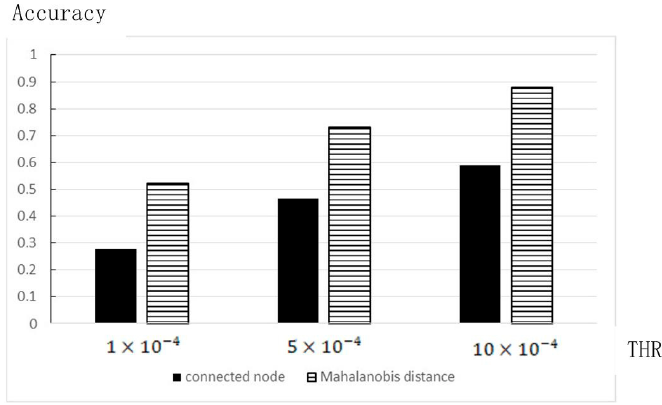
Figure 7. Comparison of accuracy rates when k = 4.